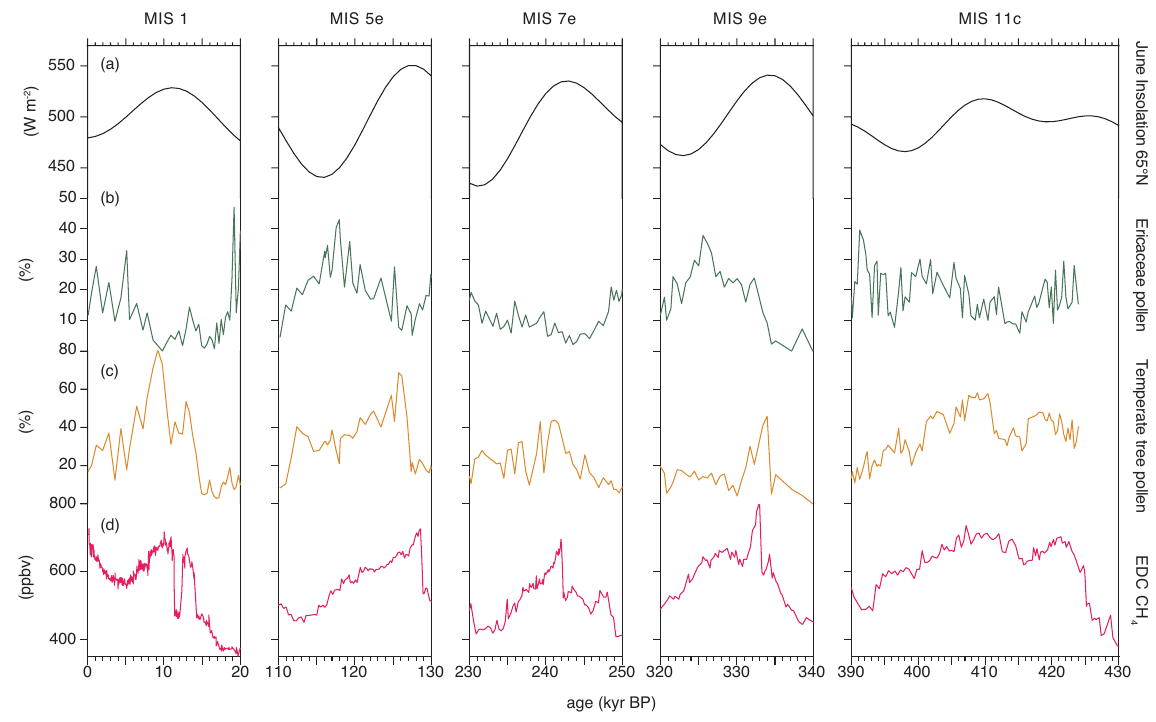
Fig. 3. Comparison of Holocene trends with those of the last four interglacials. (a) 21 June insolation 65 ◦ N (Berger and Loutre, 1991); (b) heathland (Ericaceae) pollen percentages in Portugal; (c) temperate tree (Eurosiberian and mediterranean taxa) pollen percentages in Portugal; (d) atmospheric CH 4 concentration from the EDC ice core (Loulergue et al., 2008), plotted on the EDC3 timescale. The pollen records used are from deep-sea cores on the Portuguese margin: MD01-2443 for MIS 7e, 9e, 11c (Tzedakis et al., 2004, 2009; Roucoux et al., 2006); MD95-2042 for MIS 5e (Sanchez Go˜ni et al., 1999; Shackleton et al., 2002); and SU8118 for the last 20kyr (Turon et al., 2003) (see text for details of age models). Note that the Ericaceae curves are not intended to show any similarity to the methane record, but are used here to denote that the expansion of heathland is a consistent feature of the later part of the interglacial succession when summer insolation is